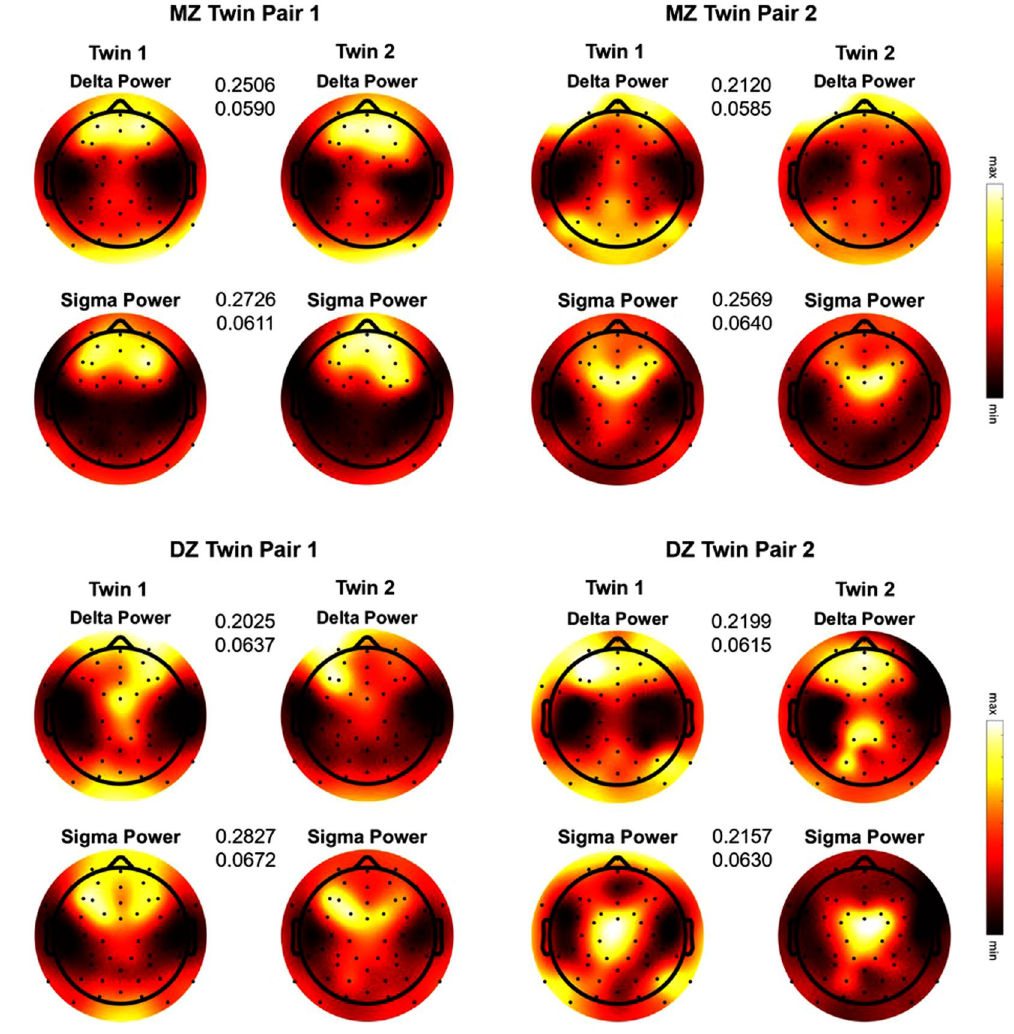
Figure 4. Topographic distribution of normalized EEG power during NREMS for two exemplary MZ and DZ pairs. Greater similarity in the pattern within the MZ pairs as compared to the DZ pairs is visually apparent. The maps were scaled within a twin pair for each frequency band